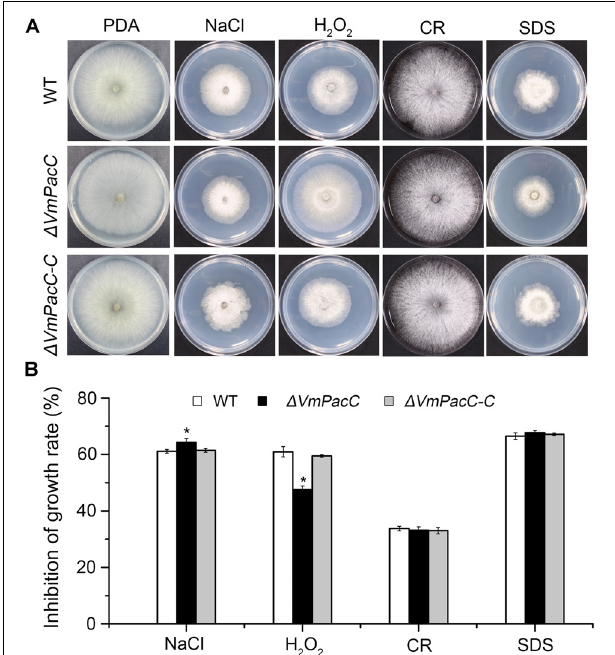
FIGURE 3 | Effects of inactivation of VmPacC gene on the response of V. mali to stress. (A) Cultures of the wild-type, VmPacC gene null mutant, and complemented strains grown on PDA supplemented with 1 M sorbitol, 0.1 M NaCl, 3 mM H 2 O 2 , 300 mg/L Congo red (CR), or 0.01% SDS. Images were taken after 2.5 days on PDA and 3.5 days in inhibitor medium. (B) Inhibition of growth (colony diameter) on PDA supplemented with inhibitor compared with PDA without stress. The asterisk represents a statistically significant difference compared to wild-type ( P < 0.05). Bars indicate standard deviations of the mean of three